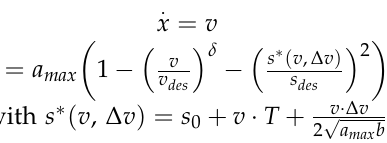
preceding vehicle. Parameters T, b, and δ are the desired time headway, comfortable braking deceleration, and acceleration exponent.